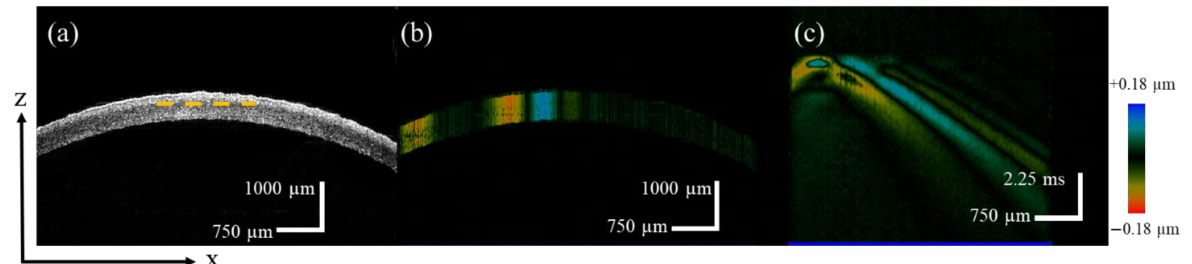
Figure 3. The ARF-OCE experiment results of the normal cornea, ( a ) is the structure image of the cornea in OCT B-scan, ( b ) is the vibration mapping in the OCE B-scan, and ( c ) is the spatial-temporal displacement diagram of the Lamb wave.